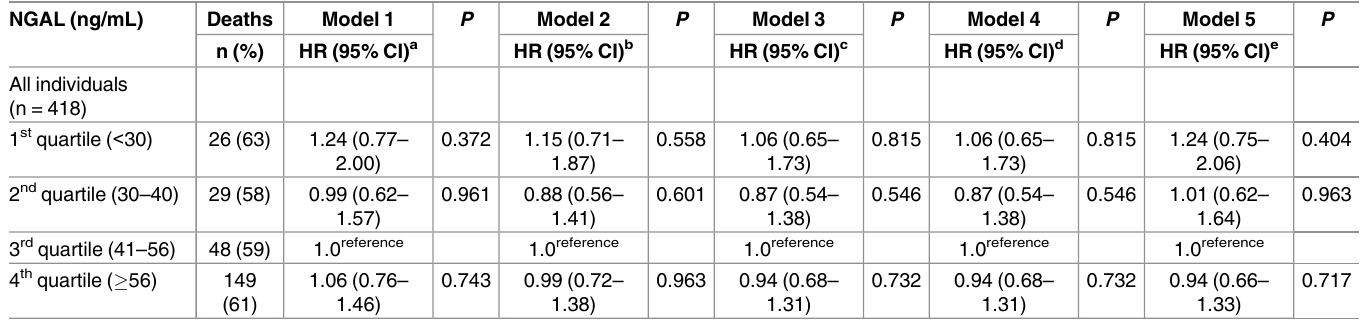
Table 7. Hazard ratios (HR) for death from all causes according to NGAL (eGFR (cid:20) 60 ml/min/1.73 m 2 ). NGAL (ng/mL)